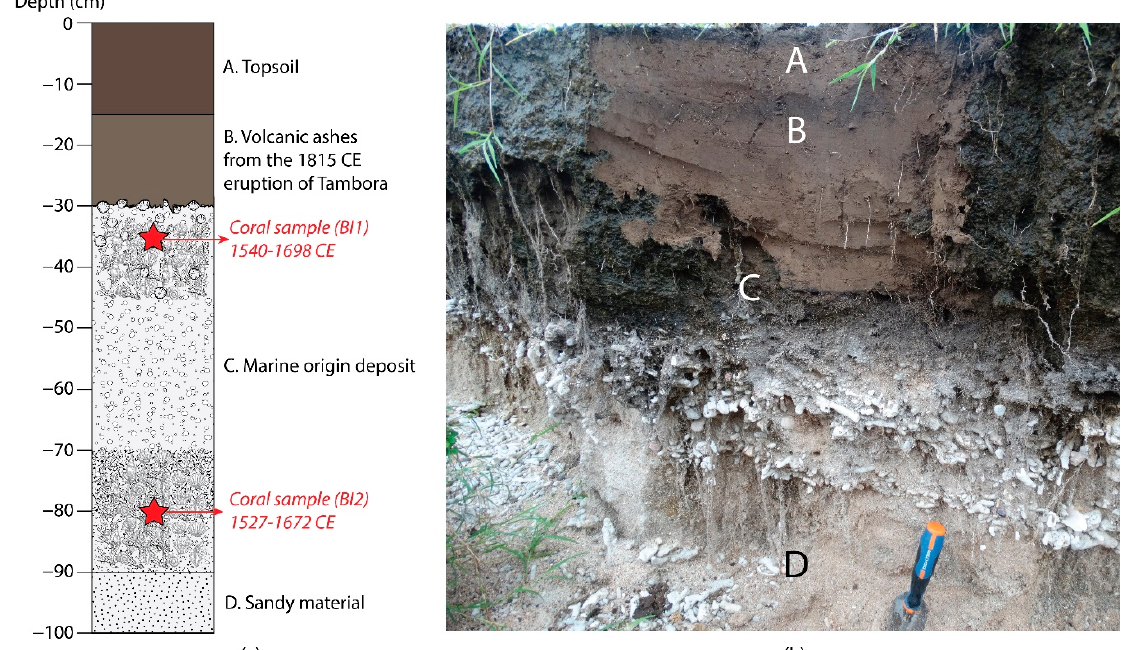
Figure 4. ( a ) The stratigraphic profile and ( b ) photo of T6 outcrop in Belang Island. The sedimentary succession described between − 30 and − 90 cm from the surface is characterized by two layers of coarse sediment and large bioclasts separated by a coarse sand layer, which is not typical of a beach deposit. The presence of rounded pumice from